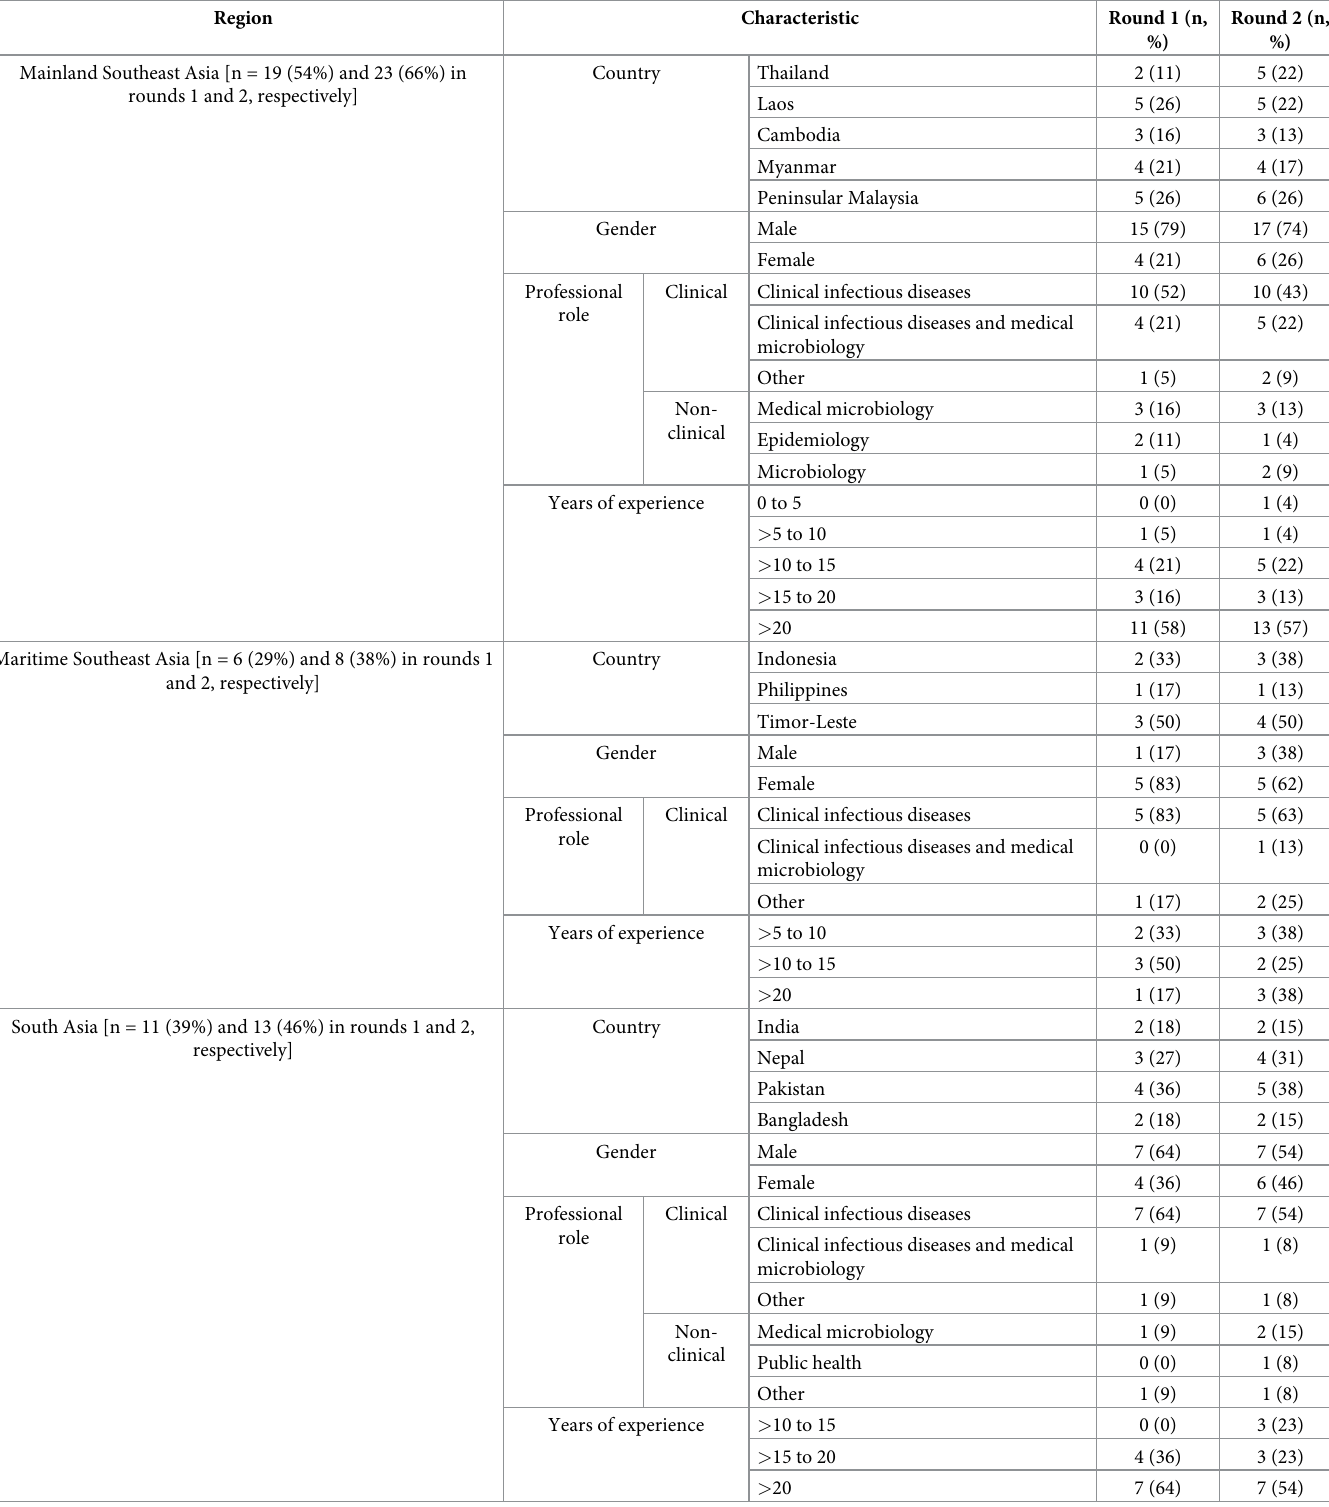
Table 1. Regional panel participant demographic and professional background